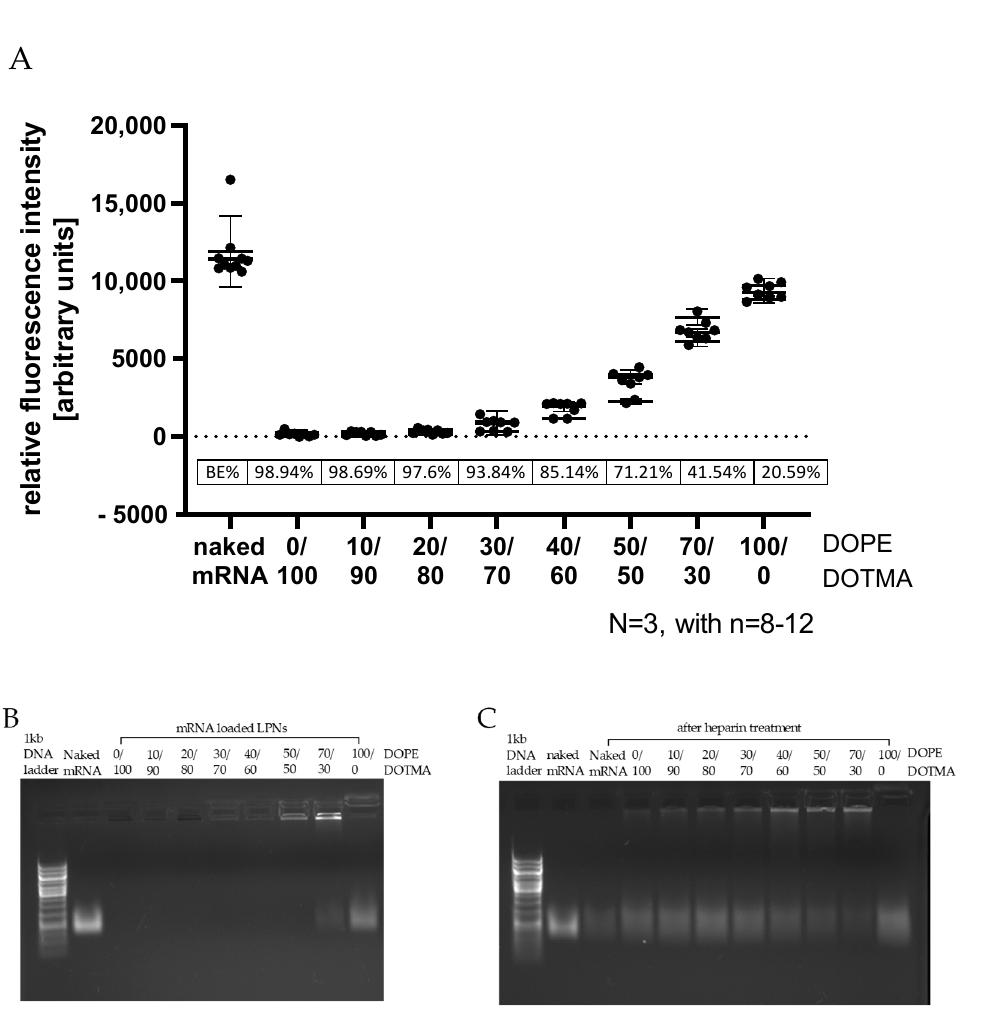
Figure 4. mRNA binding efficacy of LPN. ( A ): Quantification of mRNA fraction accessible for RiboGreen ® dye binding and binding efficacy relative to naked mRNA. Increasing the percentage of DOPE (>20%) decreases the packing density of mRNA on LPNs. ( B ): Gel electrophoresis of mRNA- loaded LPNs. Effect of increased DOPE amount to reduce binding strength is confirmed. ( C ): Gel electrophoresis of mRNA-loaded LPNs following heparin treatment. Polyanion competition re- leases mRNA partially and is dependent on the lipid ratio.